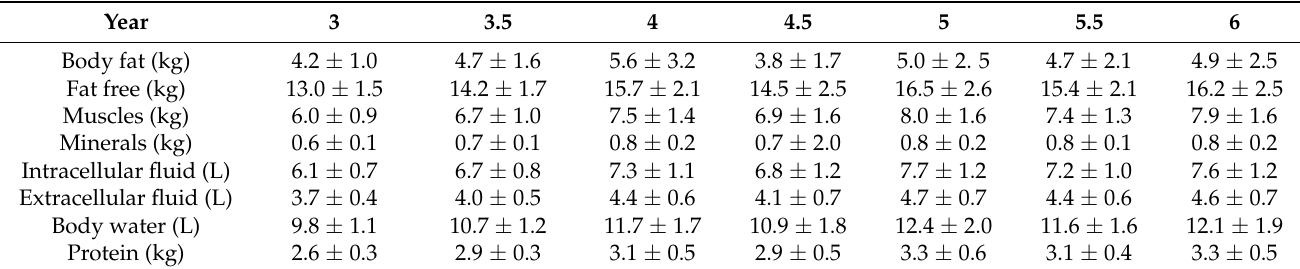
Table 6. Body composition of girls aged 3~6 ( X ± SD, n = 309).